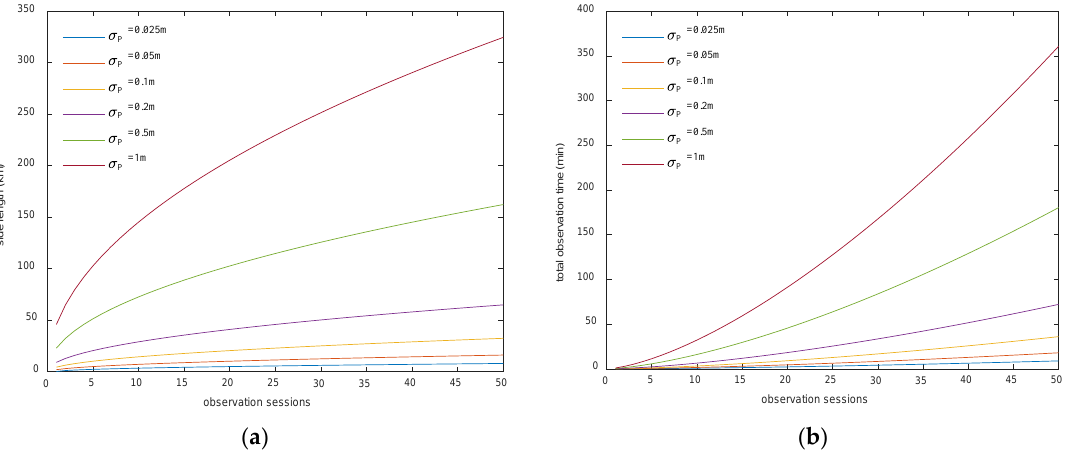
Figure 11. ( a ) The relations between the side length of the equilateral triangle unit network and the number of observation sessions at all precision levels; ( b ) The relations between the total observation time in the equilateral triangle unit network and observation